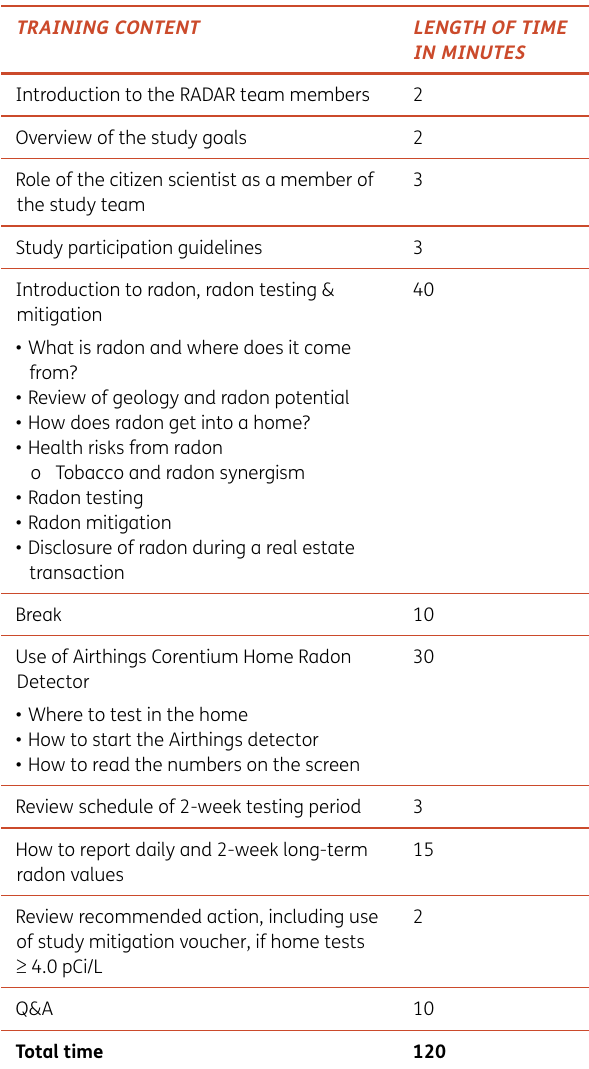
Table 1 Citizen Science